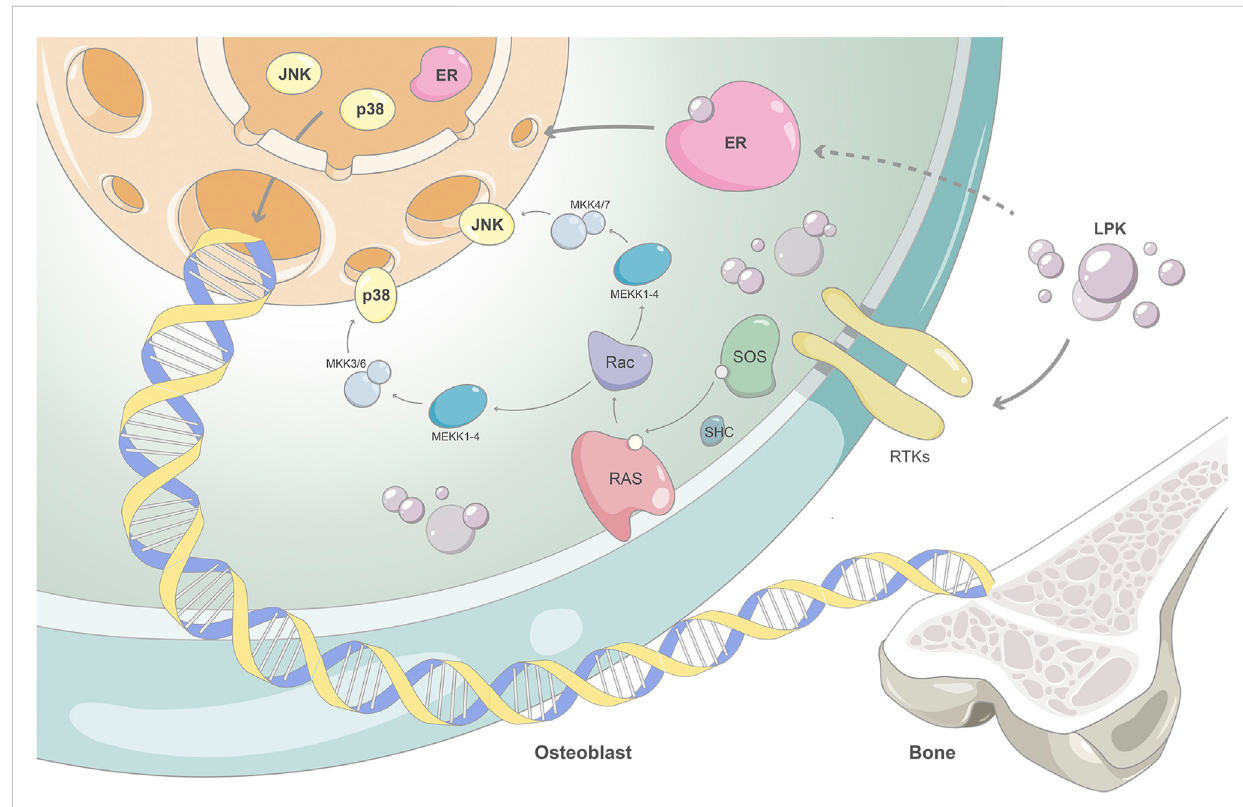
FIGURE 8 The proposed mechanism of action of Sipunculus nudus tripeptide LPK in promoting bone formation.